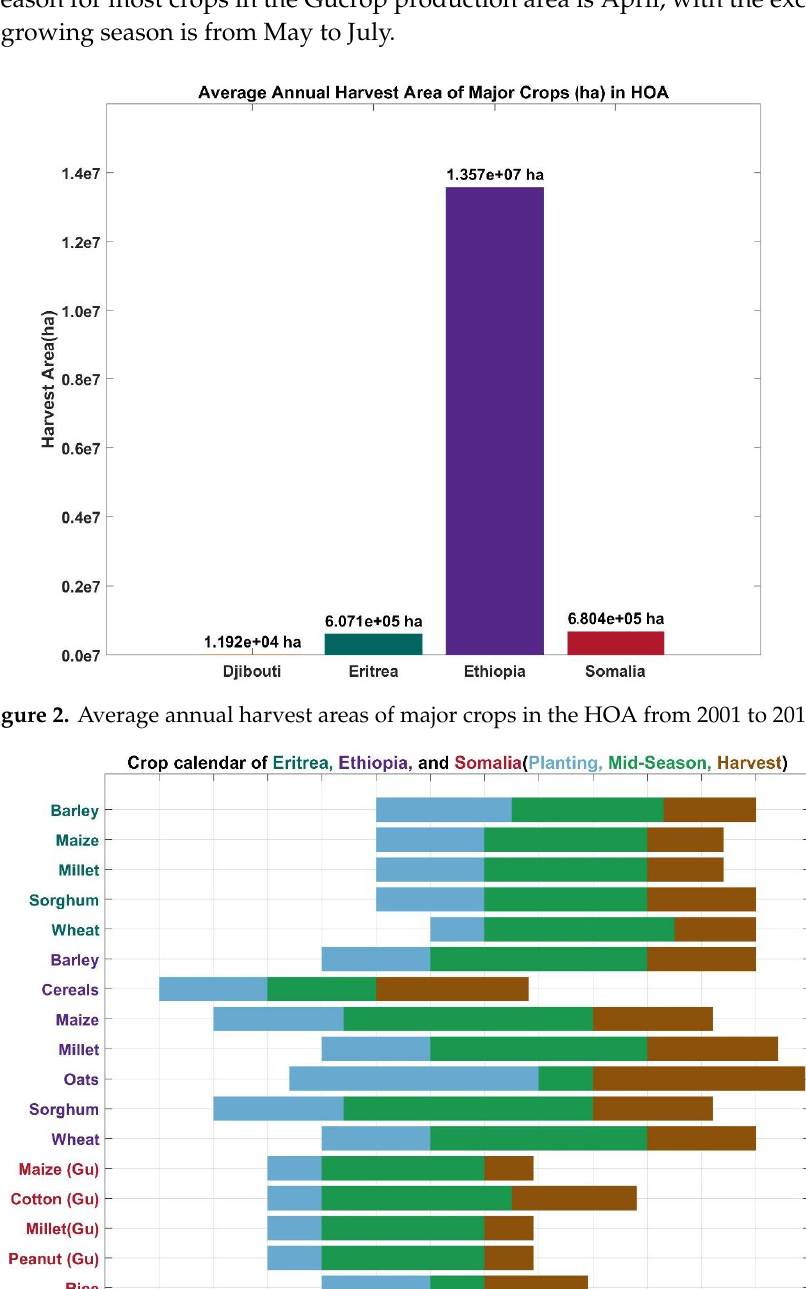
Figure 1. Map of the Horn of Africa (HOA), the selected study area.